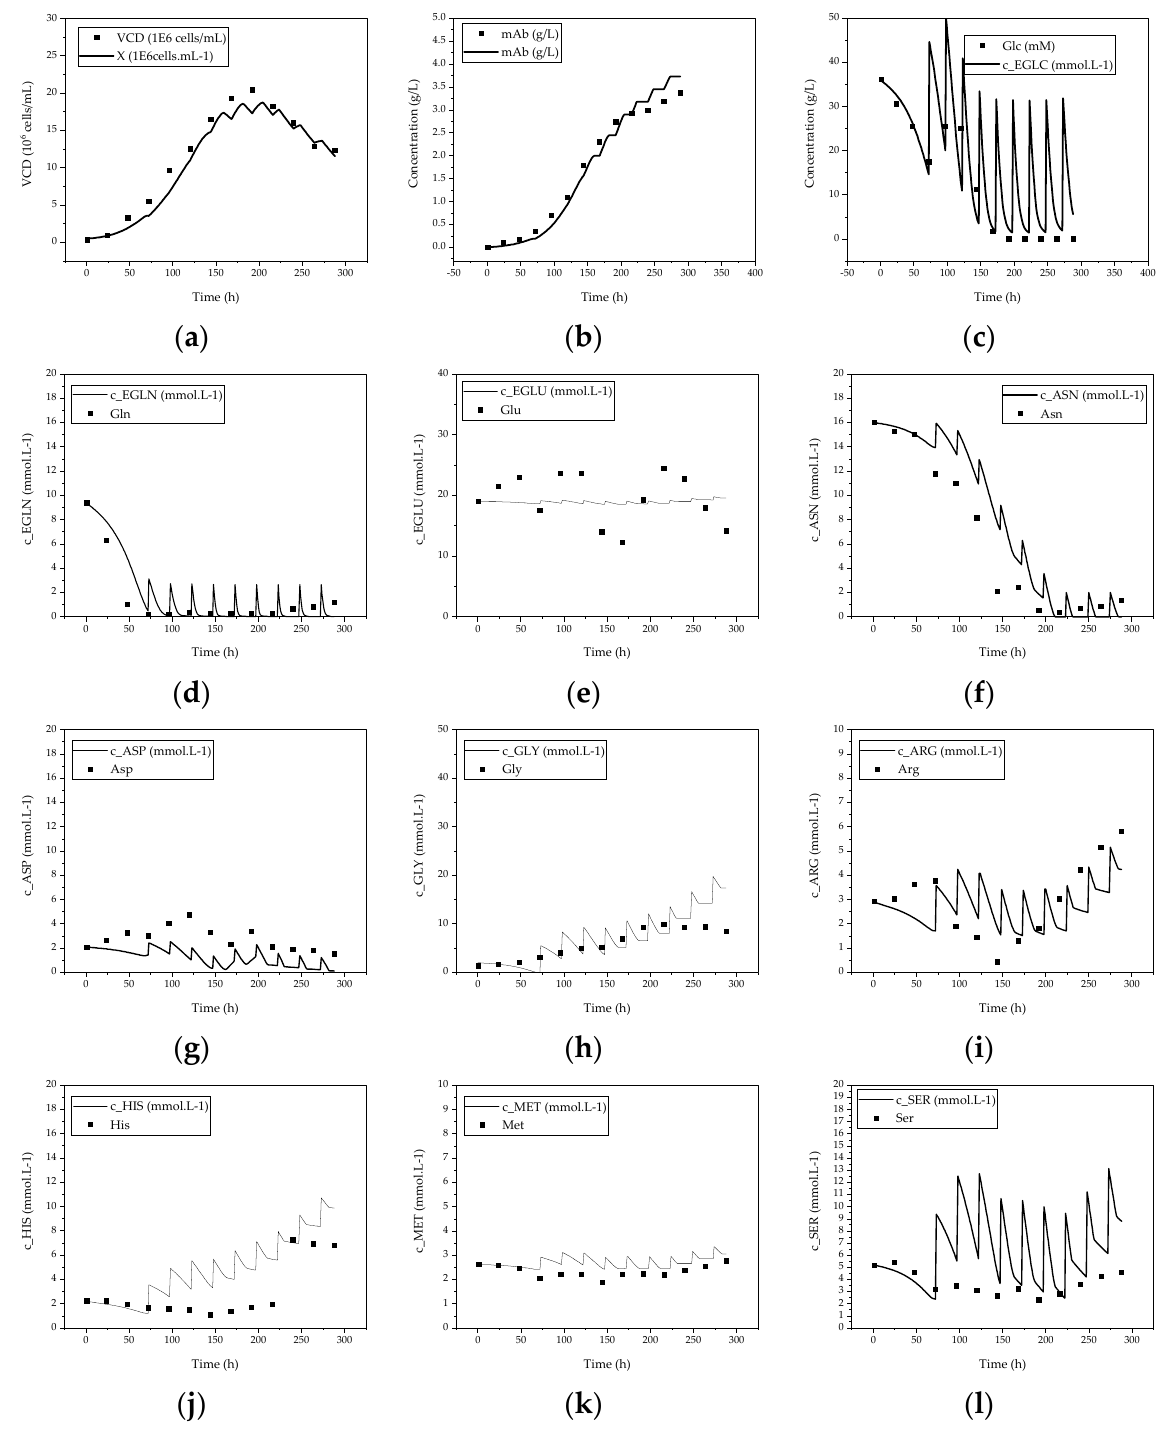
Figure 5. Simulation results of ( a ) viable cell concentration, ( b ) mAb concentration, ( c ) glucose concentration, ( d ) glutamine concentration, ( e ) glutamic acid concentration, ( f ) asparagine concentration, ( g ) aspartic acid concentration, ( h ) glycine concentration, ( i ) arginine concentration, ( j ) histidine concentration, ( k ) methionine concentration, and ( l ) serine concentration.